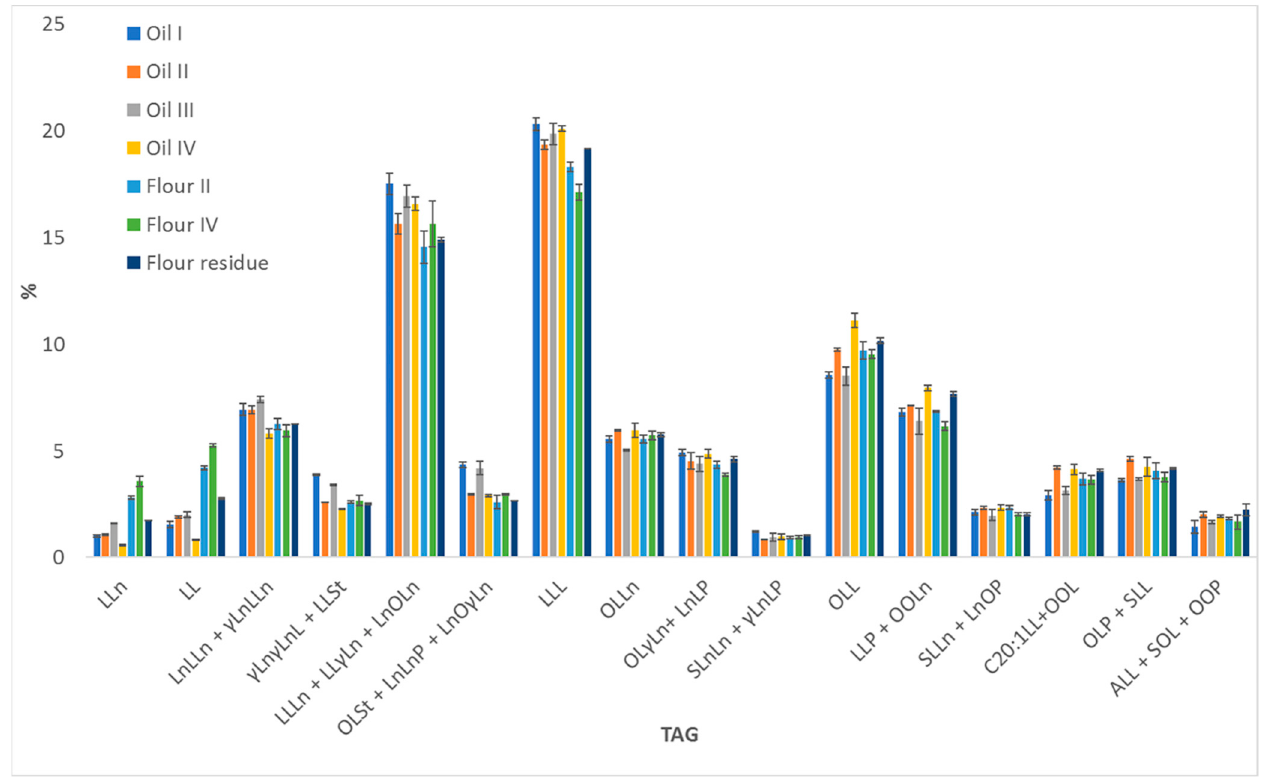
Figure 5. Comparative histogram (% content) of major DAGs and TAGs in the lipid fraction of hempseed products.